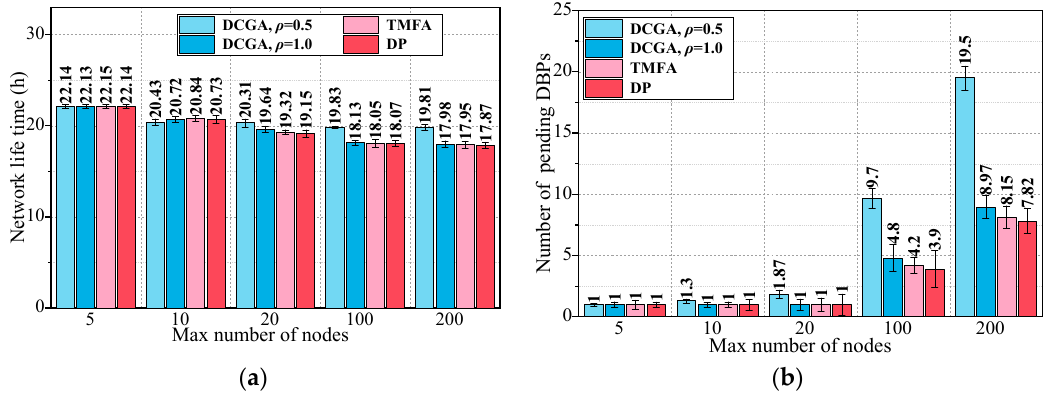
Figure 15. Results of Scenario 3. ( a ) Network life time with different maximum number of nodes; ( b ) number of pending DBPs with different maximum number of nodes.